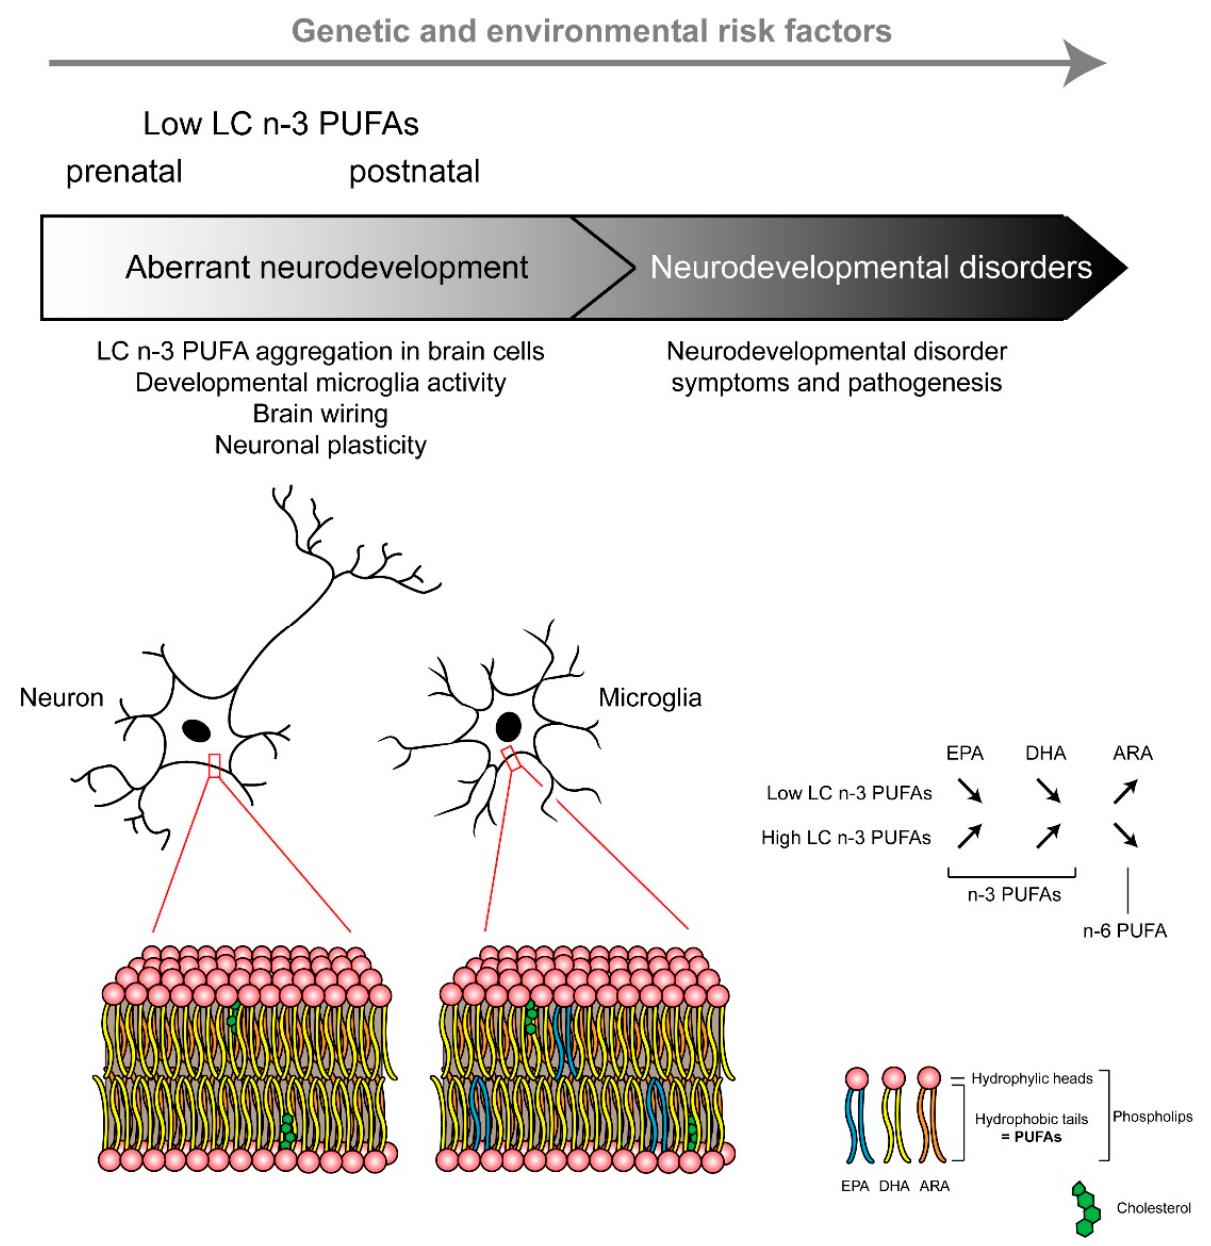
Figure 2. Hypothetical summary of events leading to neurodevelopmental disorders. Aberrant neurodevelopment can lead to neurodevelopmental disorders following inadequate levels of LC n-3 PUFAs.